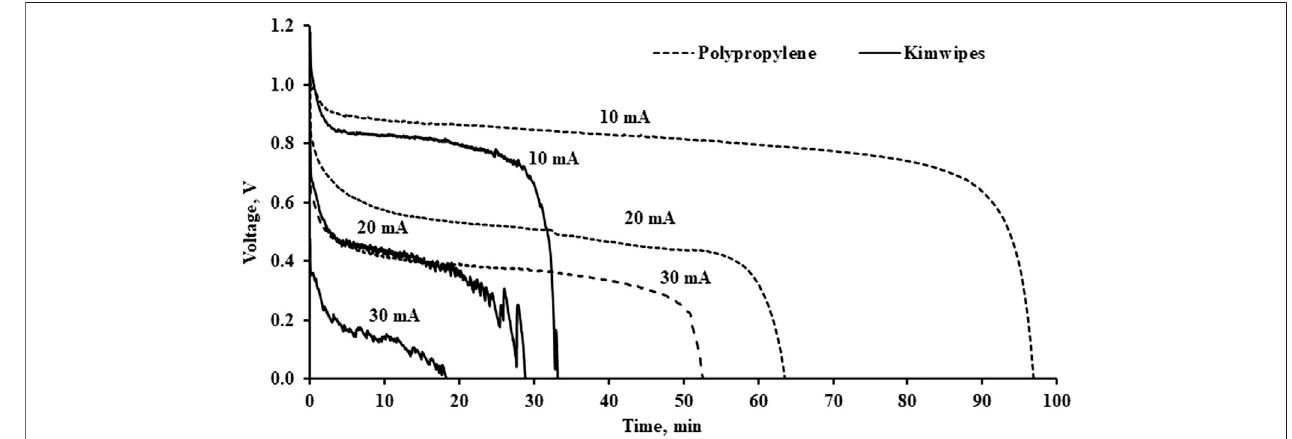
FIGURE 7 | Discharge performance of polypropylene against kim wipes as the